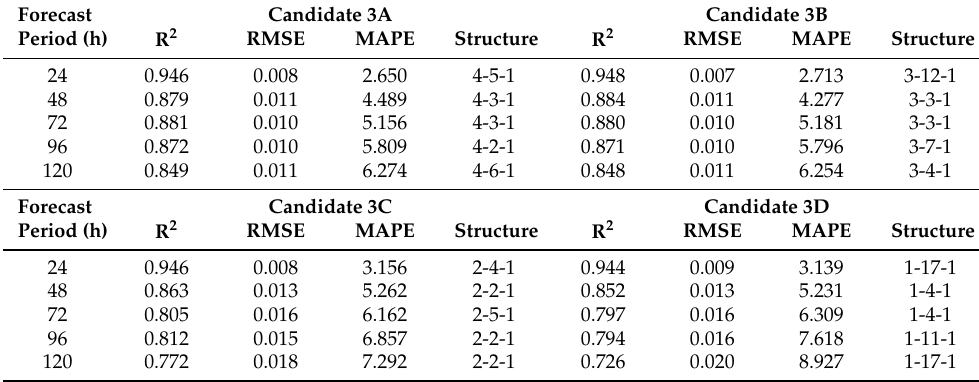
Table A6. The validation results of the combined model(HWL) fitted with